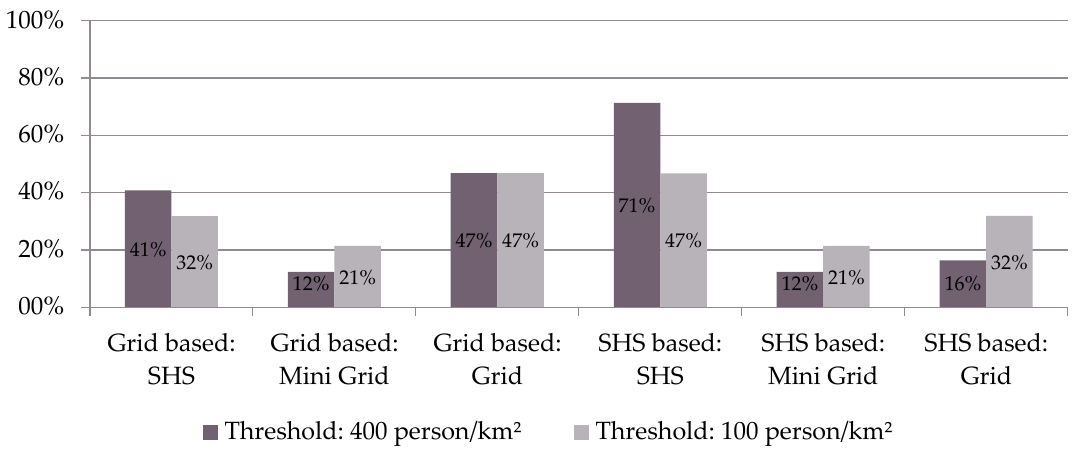
Figure 8. Results of sensitivity analysis for the parameter population threshold. The bar diagram shows the results for all considered countries for the base study with a threshold of 400 persons/km 2 (base scenario) and for comparison for a threshold of 100 person/km 2 for grid based and SHS based scenarios.